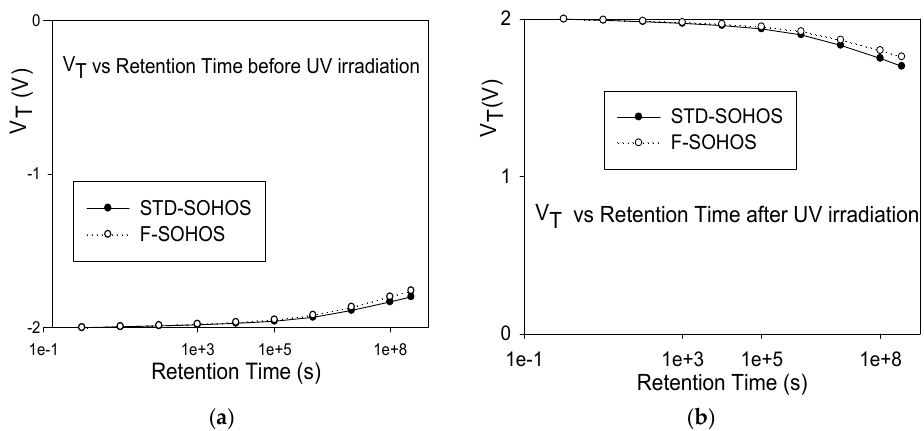
Figure 6. The comparison of V T vs. retention time for F-SOHOS and STD-SOHOS devices: ( a ) before UV irradiation; ( b ) after UV TD 100 mW·s/cm 2 irradiation under gate PVS 20